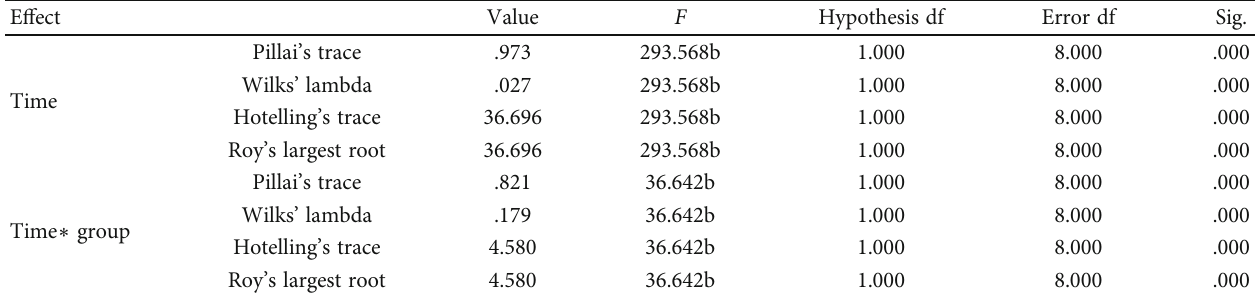
Table 3: Multivariate analysis of variance test results for within-group factors a .